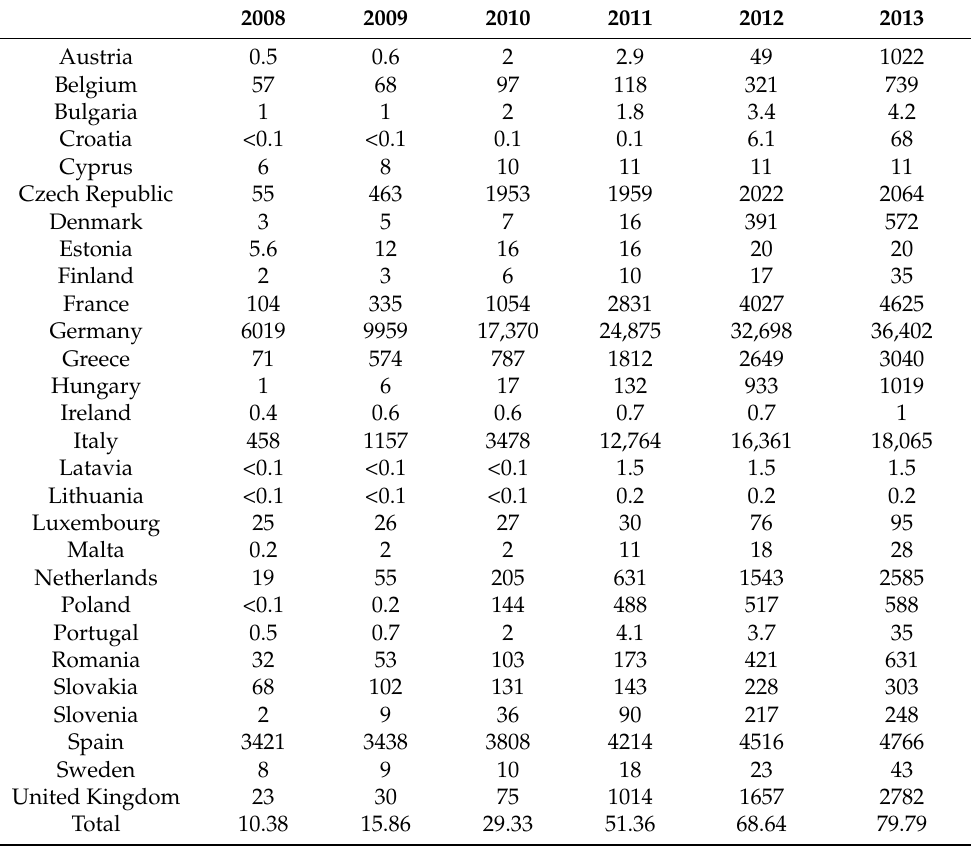
Table 2. Photovoltaic capacity in European Union countries in years 2008–2003